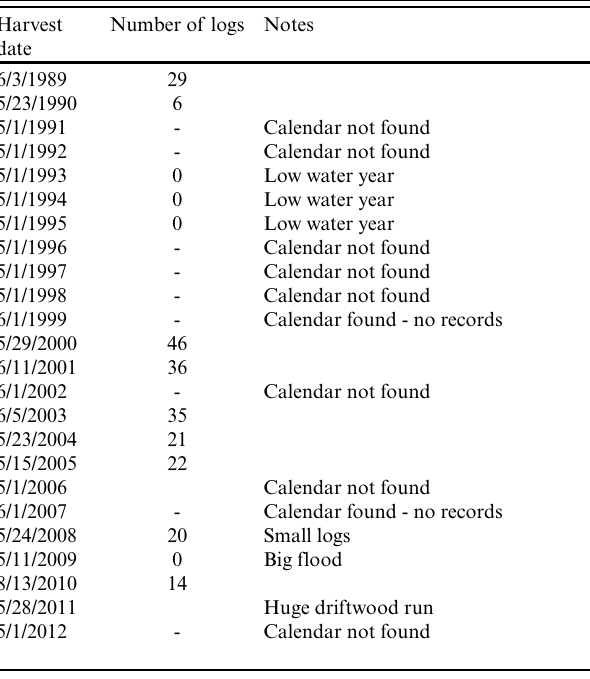
Table 1 . Driftwood records kept by calendar year. Records kept by Mr. Tom Hyslop (Tanana,